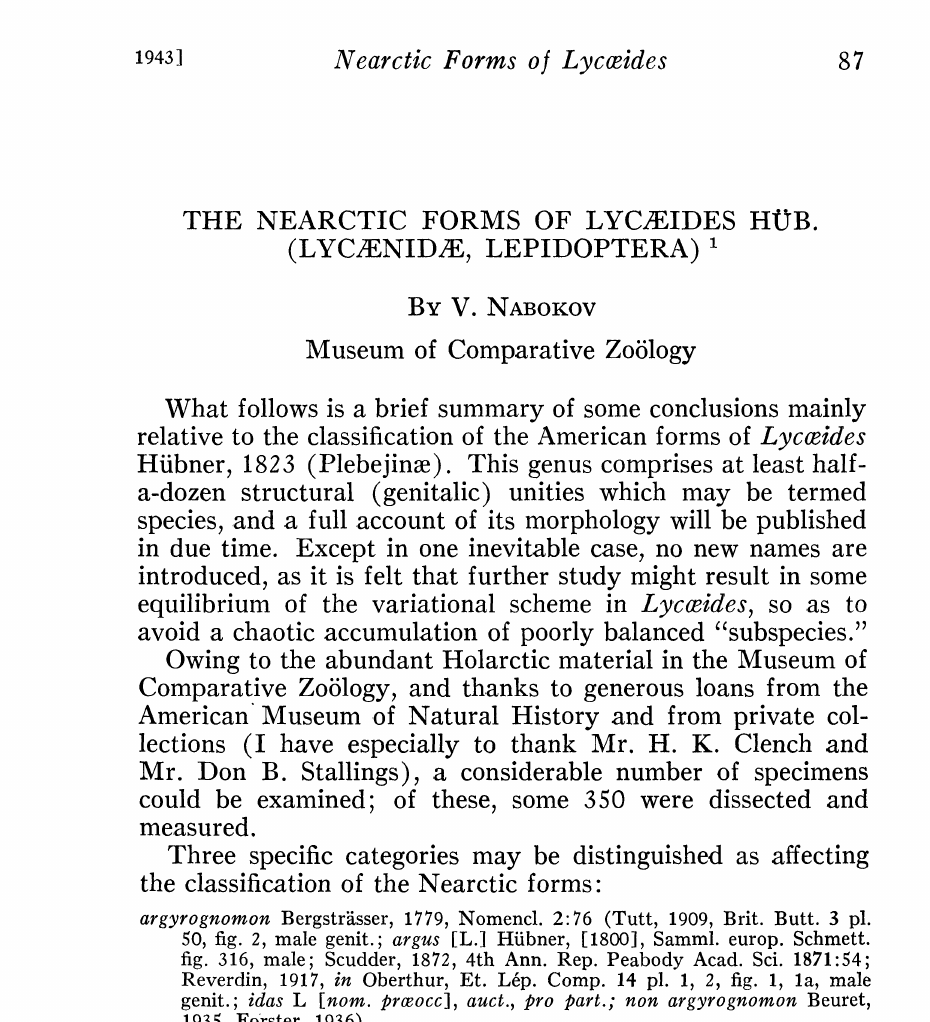
fig. 316, male; Scudder, 1872, 4th Ann. Rep. Peabody Acad. Sci. 1871:54; Reverdin, 1917, in Oberthur, Et. L6p. Comp. 14 pl. 1, 2, fig. 1, la,